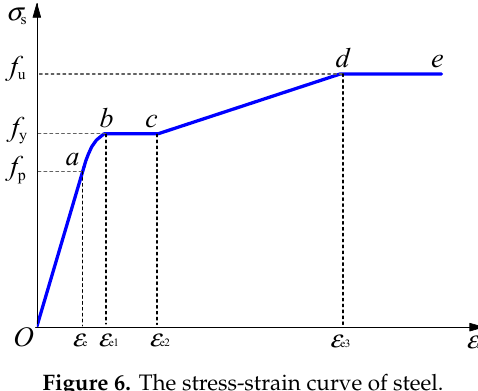
Figure 6. The stress-strain curve of steel.